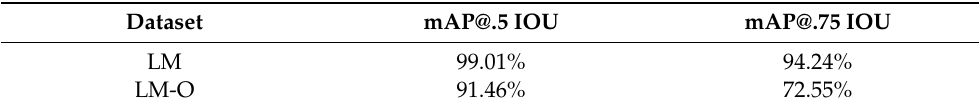
Table 3. Accuracy obtained by the YOLOV4 detection method in the LM and LM-O data sets.